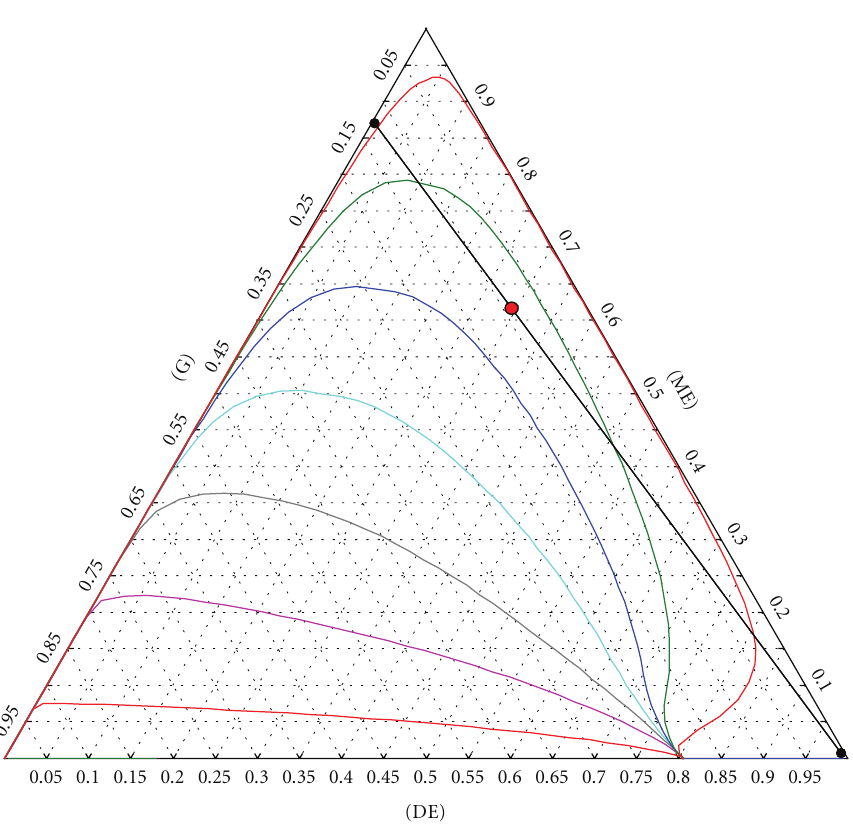
Figure 5: Residue curve map of the glycerol-monoether-diether mixture.